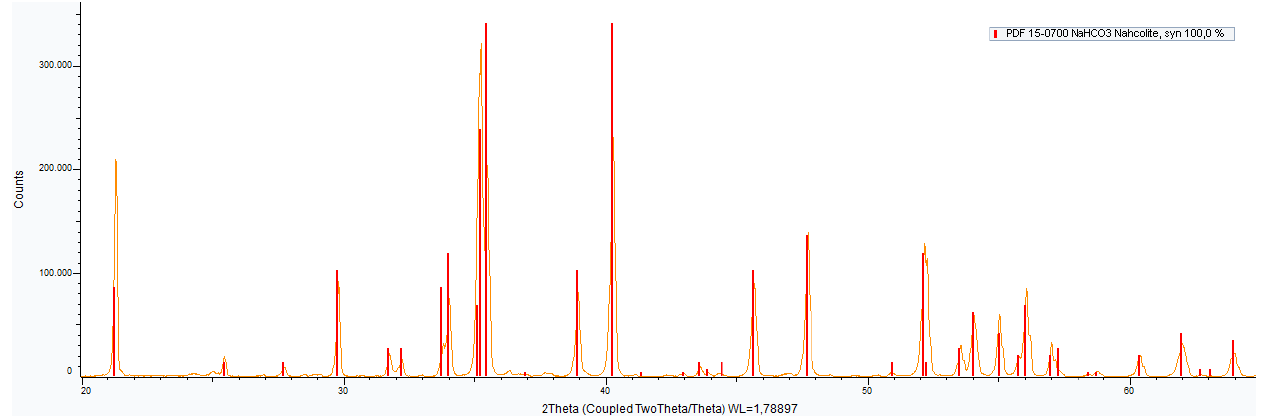
Figure B4. XRD quantitative analysis for crystals produced at 35 °C.